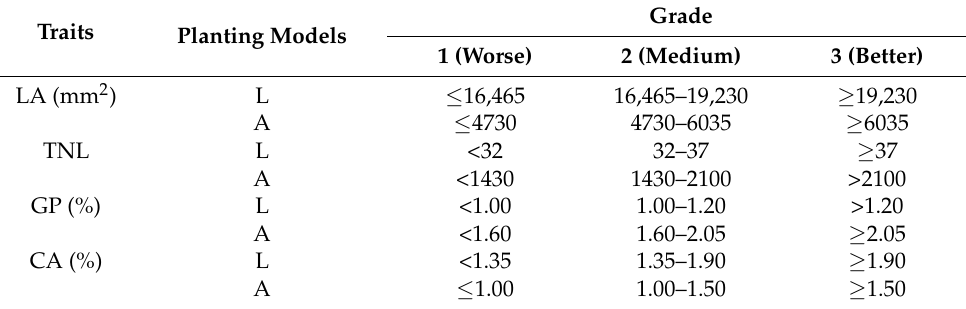
Table 5. The criterion of leaf-related traits in Eucommia ulmoides Oliver. Traits Planting